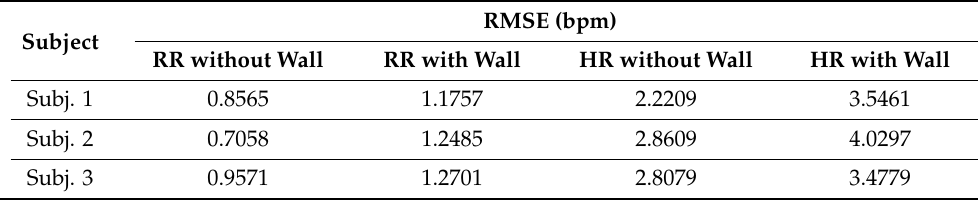
Figure 14. RR and HR monitoring results of Subject 2 in line-of-sight and through-wall cases. ( a ) Line- of-sight RR monitoring with apnea from the 12th s. ( b ) Through-wall RR monitoring. ( c ) Line-of-sight HR monitoring. ( d ) Through-wall HR monitoring. Table 4. RMSE (in bpm) of RR and HR monitoring in cases of line-of-sight (without wall) and through-wall (with wall)